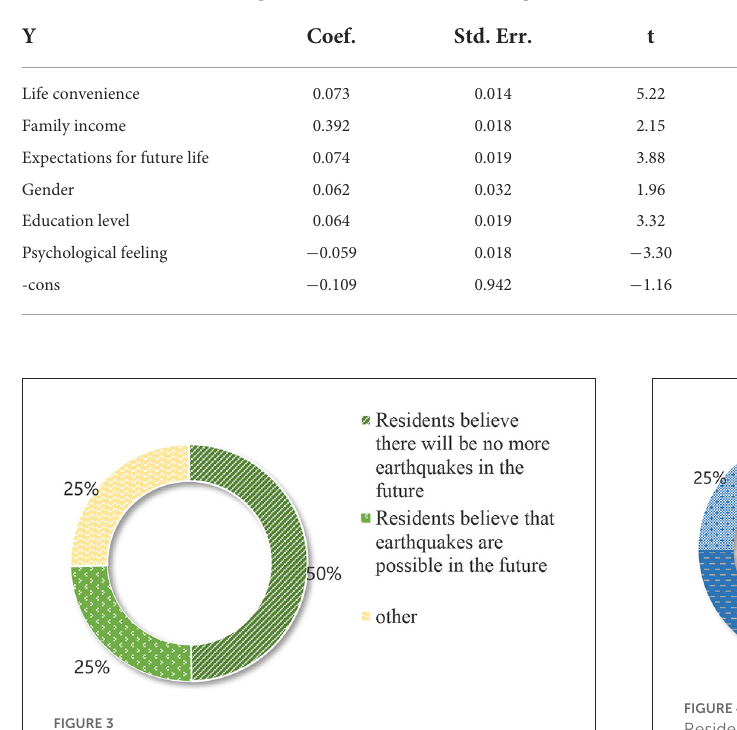
TABLE 5 Variables and willingness of residents affected to migration.